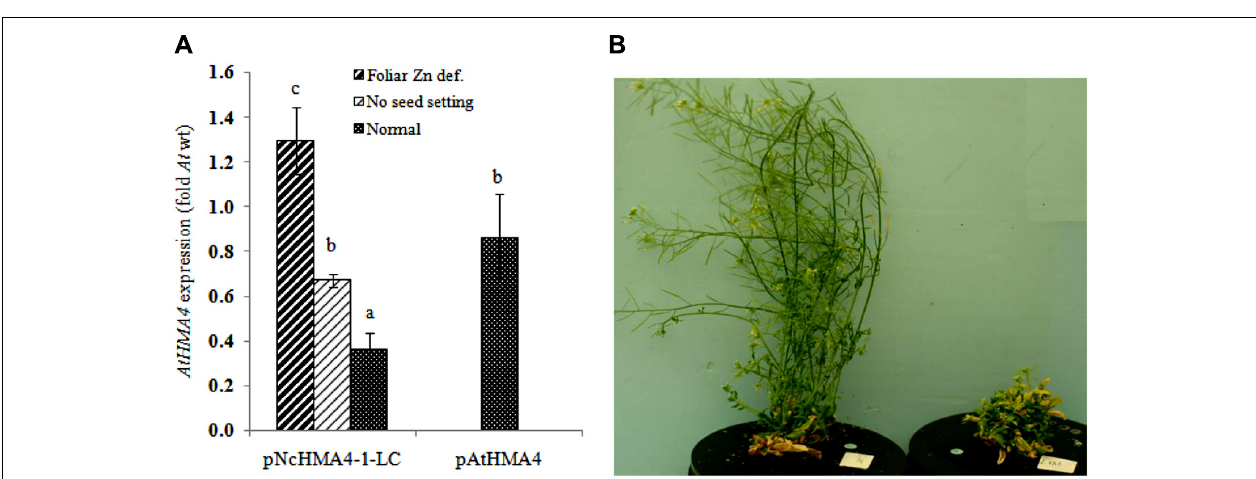
FIGURE 6 | GUS expression under the (A) and (D) pNcHMA4-1-LC , (B) and (E) pNcHMA4-2-LC in N. caerulescens roots . (C) and (F) are control roots [Scale bar = 30 μ m].